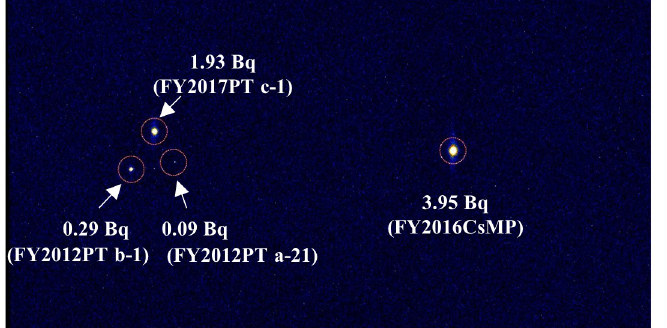
Fig 8. Radioactivities in Cs-containing particles as estimated from autoradiography. Tissue sections with Cs- containing particles (left side) were attached to the IP. The CsMP (FY2016CsMP) isolated from the parmelioid lichen by Dohi et al . [21] was used as a reference because the radioactivity was already determined (right side). The exposure time was 16 hours. The radioactivities in these Cs-containing particles were estimated.